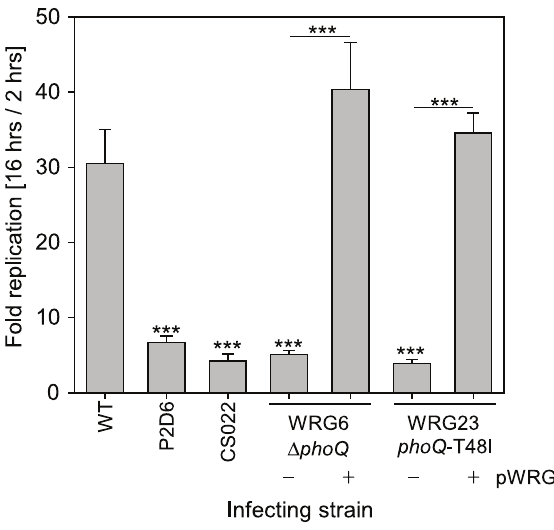
Figure 4. Quantification of intracellular survival within RAW264.7 macrophage-like cells using gentamicin protection assay. The intracellular replication rates of the mutant strains WRG6 ( D phoQ ) and WRG23 ( phoQ -T48I) were compared to S . Typhimurium WT and the previously characterized mutants P2D6 ( ssaV ::mTn 5 ) and CS022 ( pho-24 ). After infection with a MOI of 5 non-internalized bacteria were killed by gentamicin treatment and the intracellular bacteria were quantified 2 h and 16 h after infection by plating of cell lysates. Intracellular replication rates are expressed by the quotient of 16 h colony forming units (CFU) and the 2 h CFU. One representative of three independent experiments done in triplicates is shown. Statistical analysis by Student’s t -test was done by comparison with the WT or by comparing individual strains as depicted: *** P , 0.001.